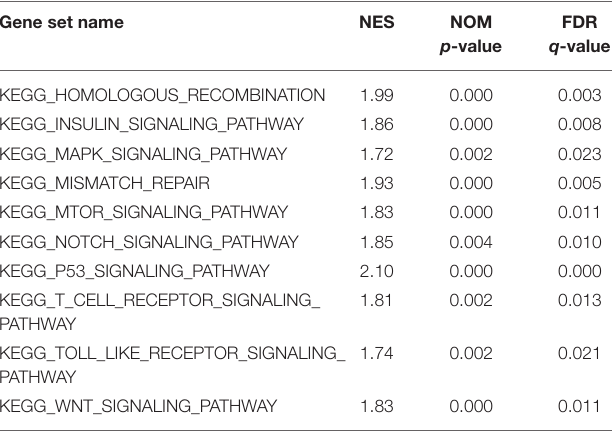
TABLE 3 | Cell division cycle-associated protein 2-related pathways screened by gene set enrichment analysis